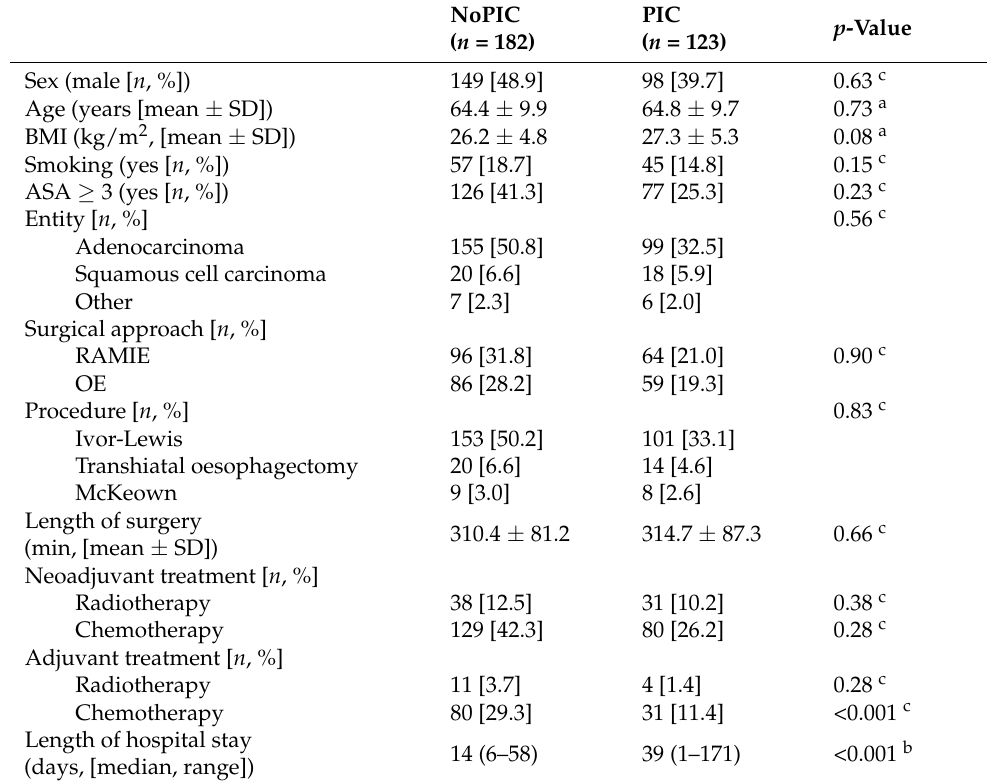
Table 2. Baseline and perioperative characteristics of patients undergoing RAMIE ( n = 160) or OE ( n = 145) stratified by PIC within 30 days after surgery. Data are presented as mean ± SD, range or relative frequencies. Continuous variables were tested using a Students’ t -test (normally distributed) and b Mann-Whitney-U test (non-normally distributed), while categorical variables were compared using c Chi-Square. ASA: American Society of Anaesthesiologists; BMI: body mass index, OE: open esophagectomy, PIC: postoperative infectious complications; POD: postoperative day; RAMIE: Robot- assisted minimally-invasive esophagectomy, SD: Standard deviation. p -values < 0.05 were considered statistically significant and are indicated in bold.